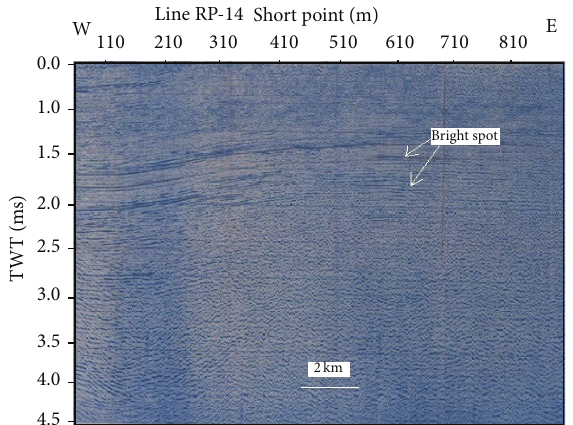
Figure 5: Seismic section along the line RP-14 showing bright spot in the structure.